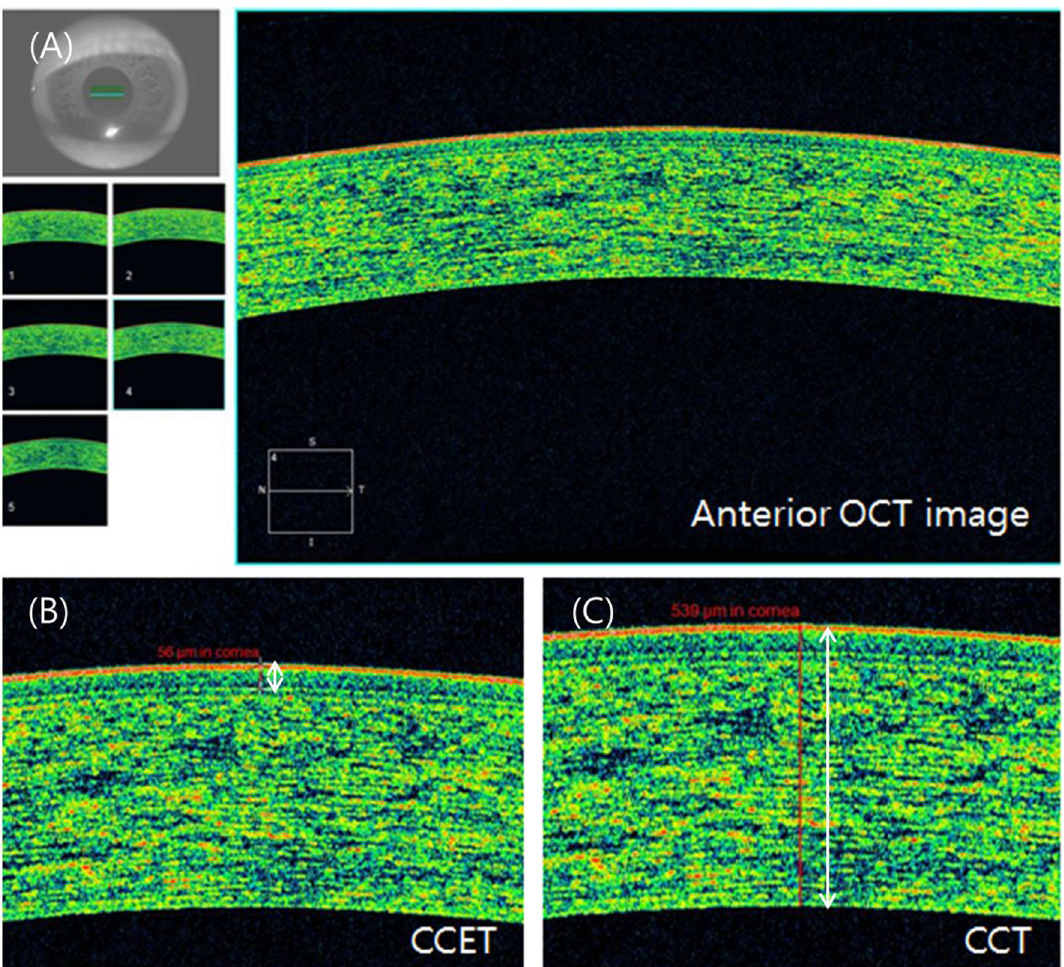
Fig 1. (A) Example of CCT measurement using Cirrus-OCT. (B) CCET was defined as the distance from the air – cornea junction to the Bowman ’ s layer line (white line). (C) CCT was defined as the distance from the air – cornea junction to the cornea – aqueous humor junction (white